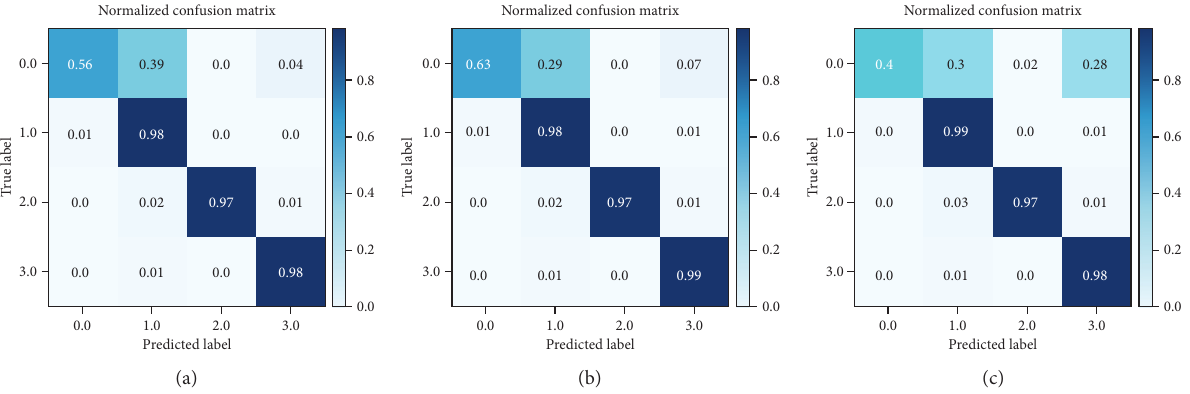
Figure 7: Confusion matrix of three gait patterns derived from Bagging classification under three paces. Settings: 0.78m/s (a), 1.0 m/s (b), and 1.25m/s (c).